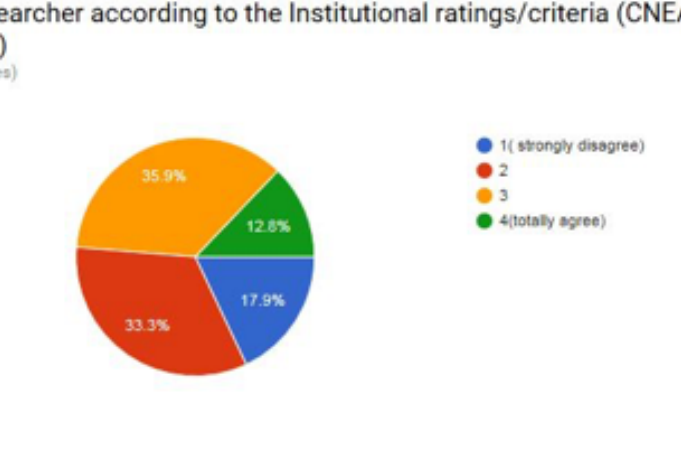
Figure 2. Answers to the question “It is necessary to be a good researcher to be a good University